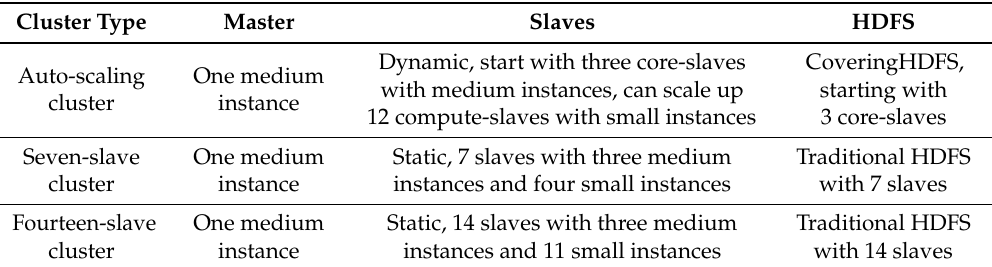
Table 1. Three types of Hadoop clusters.